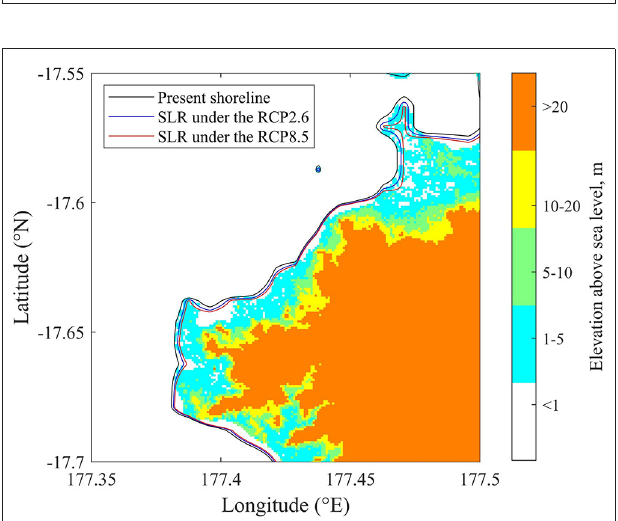
FIGURE 6 | Changes in the shoreline by SLR in location #2, Lautoka area, (see Figure 3B ) under different SLR scenarios. The black line corresponds to the coastline under present climate condition, the blue line corresponds to the retreat of coastline due to SLR under the RCP2.6 scenario, while the red line corresponds to the shift in the shoreline due to SLR under the RCP8.5 scenario.